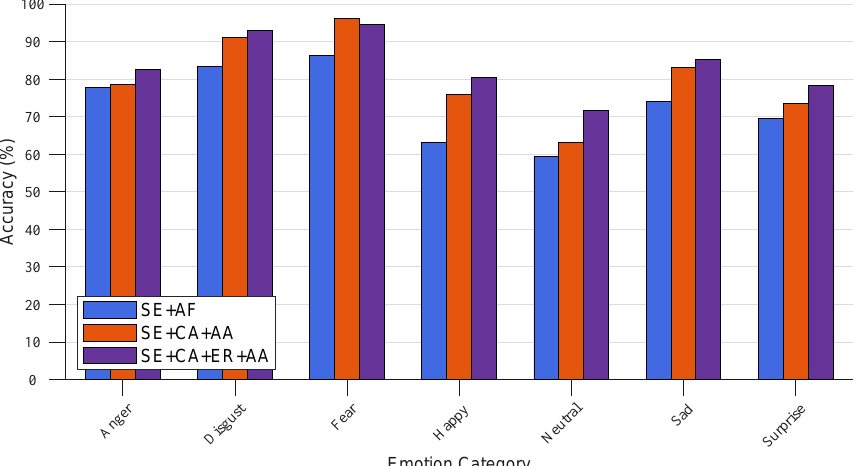
Figure 10. Comparison of emotion prediction performance among ablation networks as shown in Figure 9 on each emotion category in the CAER-S